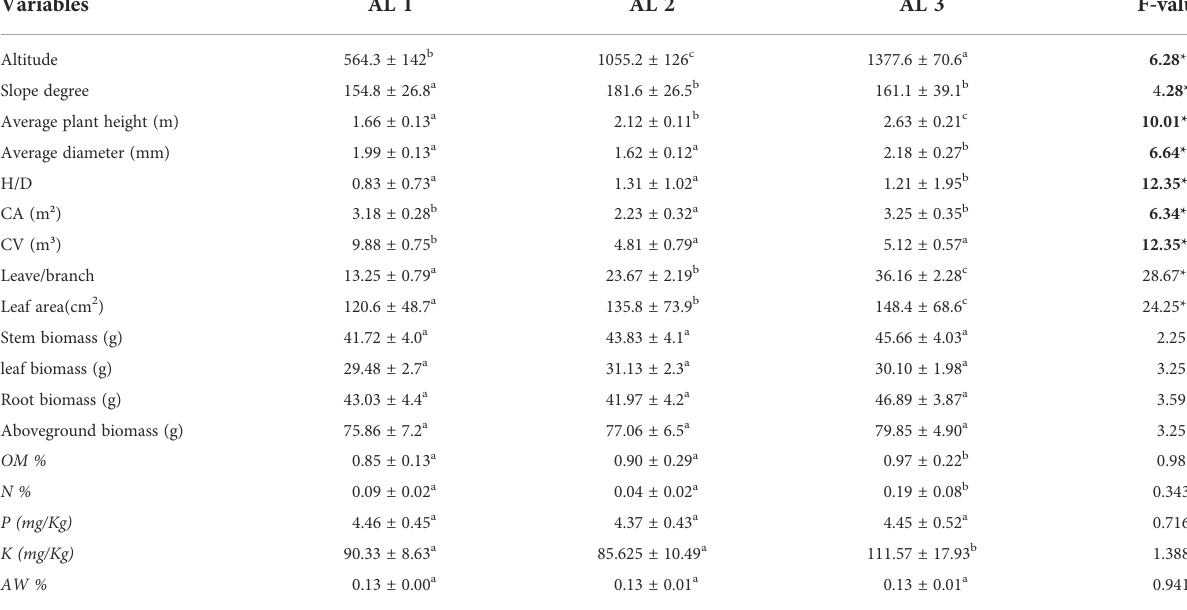
TABLE 1 Summary of morphological traits and stand description (Mean ± SE) of sample habitats and biomass component for C. procera .